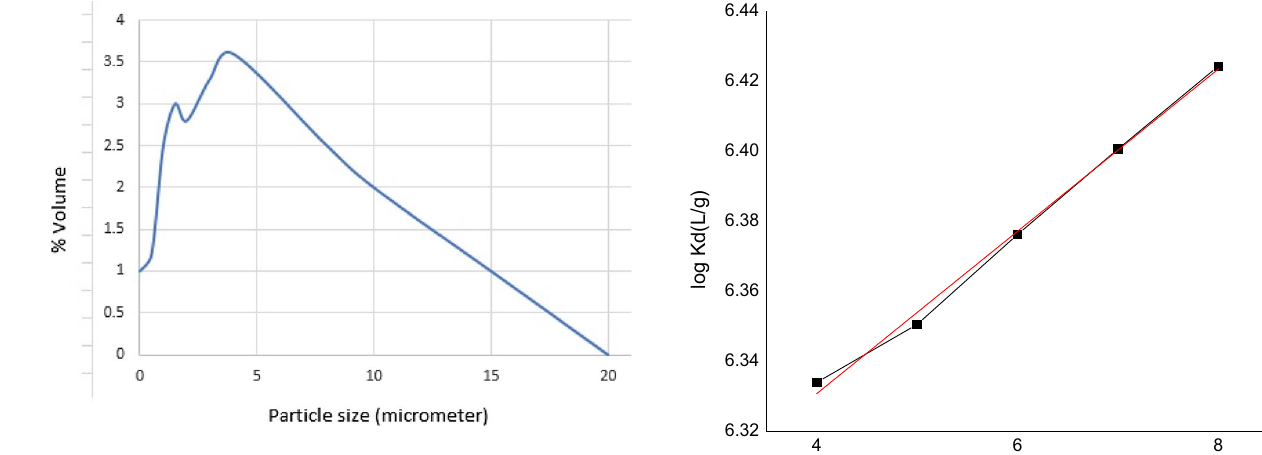
Fig. 3 Particle size distribution of kaolinite